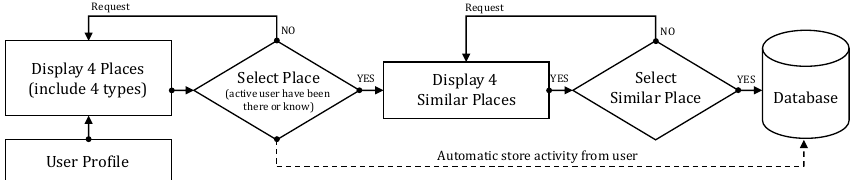
Figure 5. The process of collecting feedback from users in OurPlaces crowdsourcing